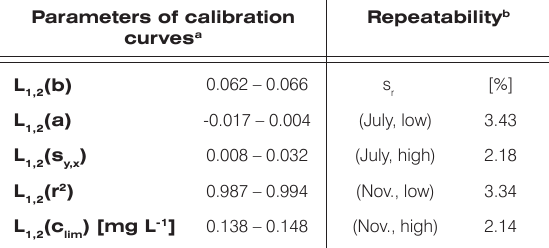
Parameters of calibration curves a